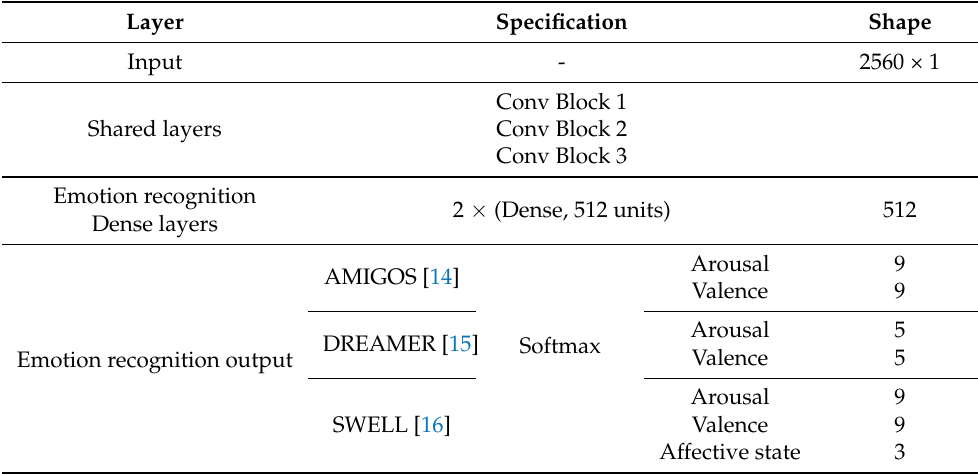
Table 3. Convolutional neural network layer structure and parameters for fully supervised training, as well as transfer learning settings/fine-tuning.